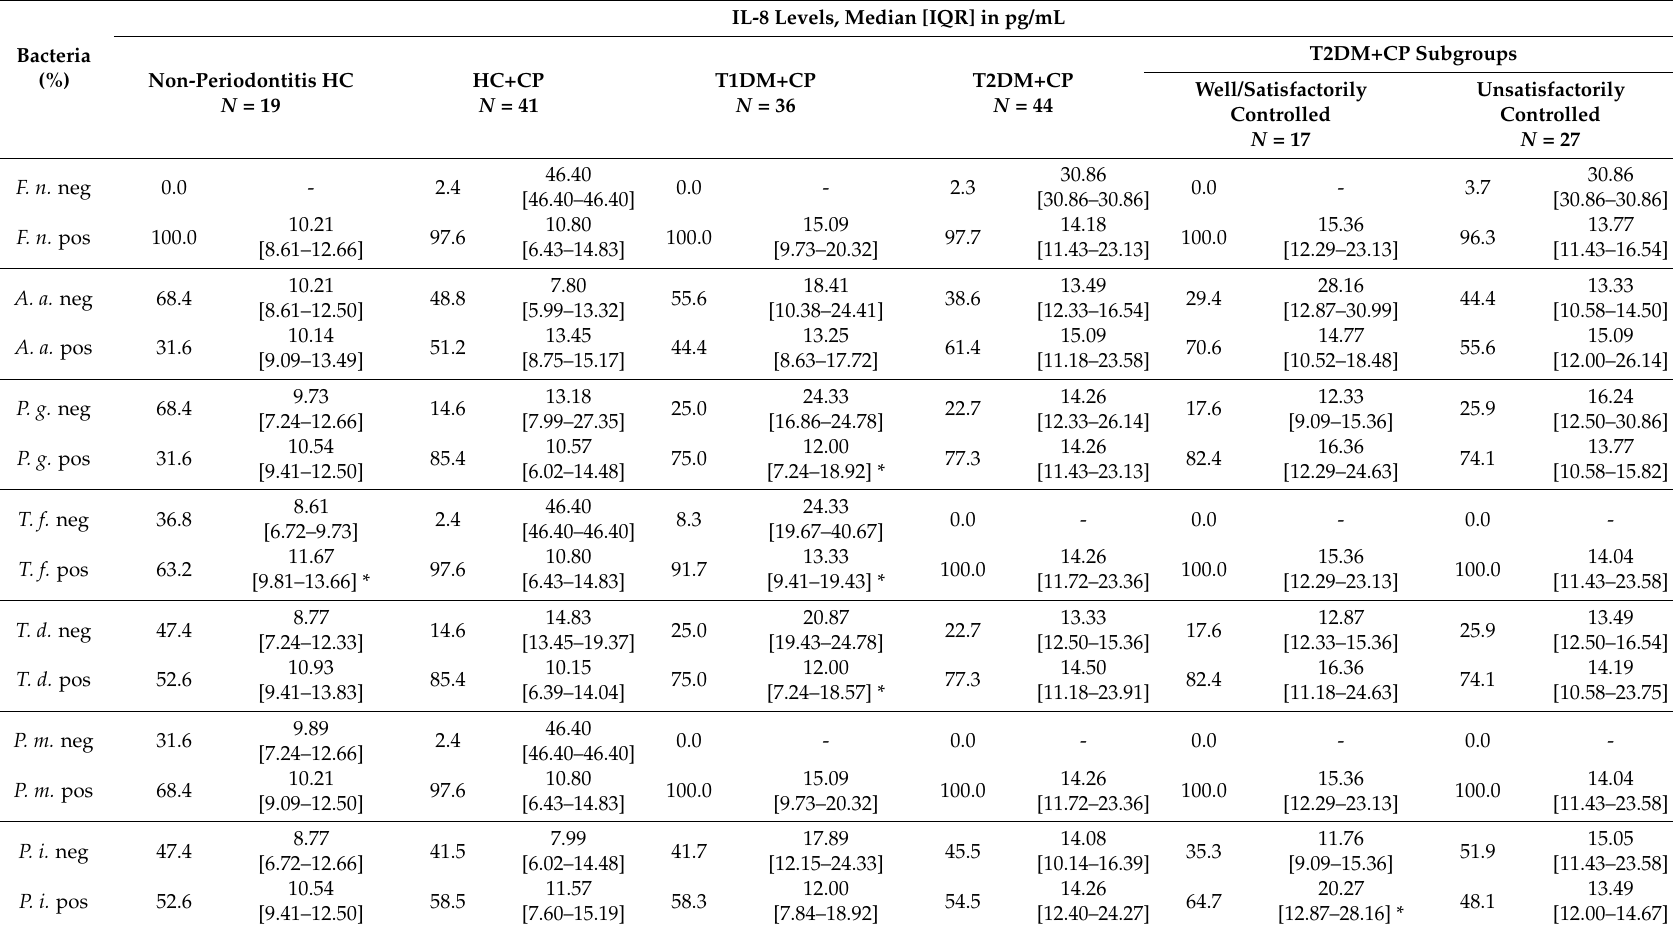
Table 5. IL-8 plasma levels and periodontal bacteria in a subgroup of 140